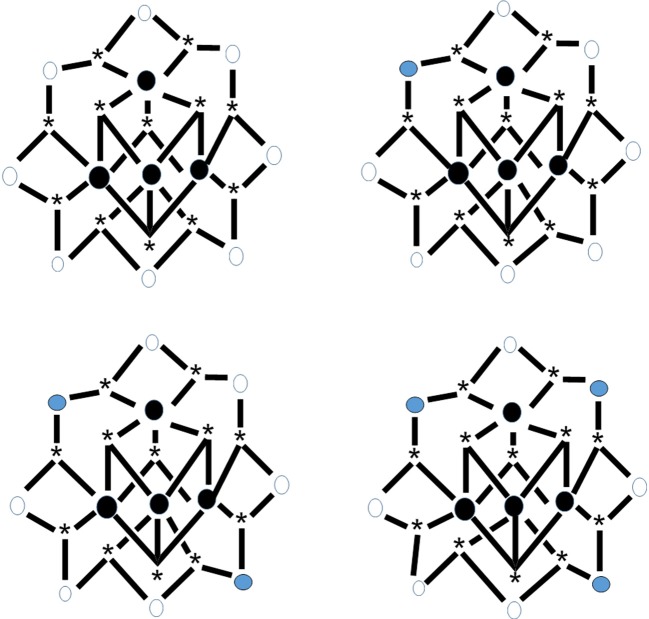
The crystallographically established {Mn12O12} cores of the {Mn12}, {Mn12}−, and {Mn12}2− SMMs, and proposed core for the {Mn12}3− SMMs. The symbol  represents MnIV, the symbol  represents MnIII, the symbol  represents MnII, and the asterisk illustrates the triply bridging O2− group (Schematic drawing inspired by Bagai and Christou, 2009). Coordination bonds are drawn in bold.